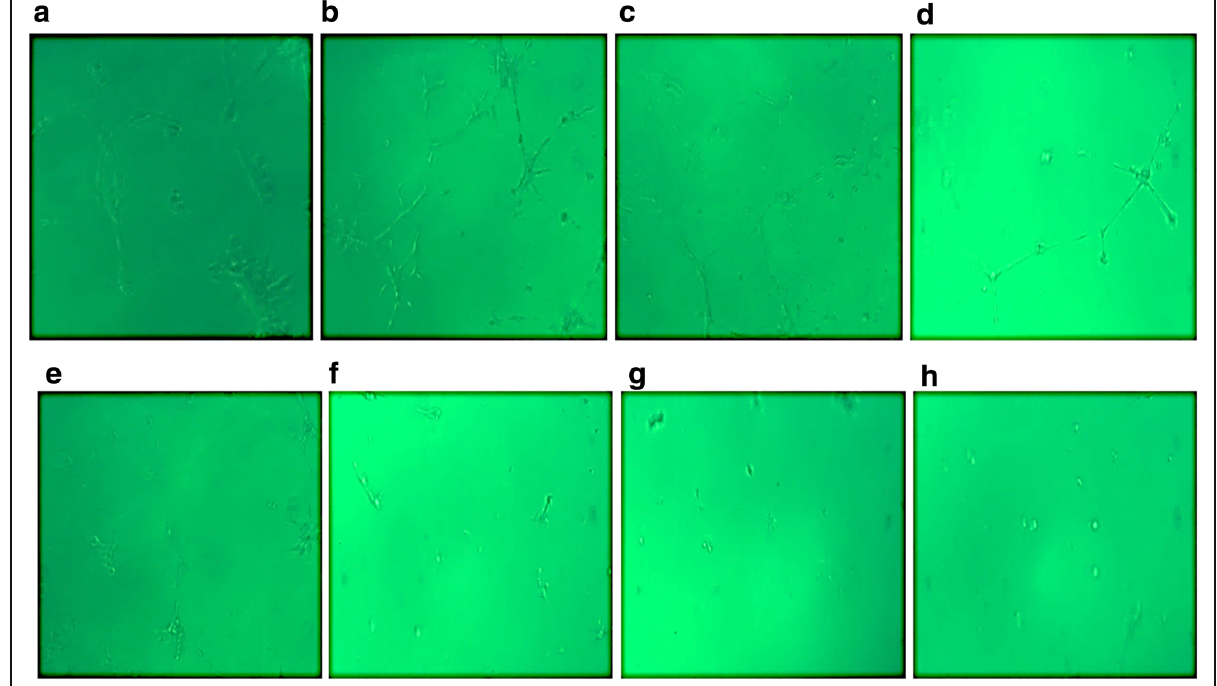
Fig. 2 Effects of crude microsytins on HUVECs tubes formation in Martigel. Various concentrations (5, 10, 20, 40 and 60 μ l/mL) of microcystin were used to study its inhibitory potential on HUVECs proliferation in Matrigel. HUVECS were seeded in 96 well microtiter plate and incubate for 24 h under various concentrations of crude microcystin (control without microcystins) and photographed randomly at three different sites. a, b represents the photographs of HUVECs in control well (HUVECs without treatment with microcystins). c, d represents the HUVECs photographs shot after treatment with the lowest concentration i.e. 5 μ l /mL of microcystin extract. e, f, g and h represent the photograph of HUVECs in different wells treated with different concentration of crude microcystin in the range of 10, 20, 40 and 60 μ l/mL